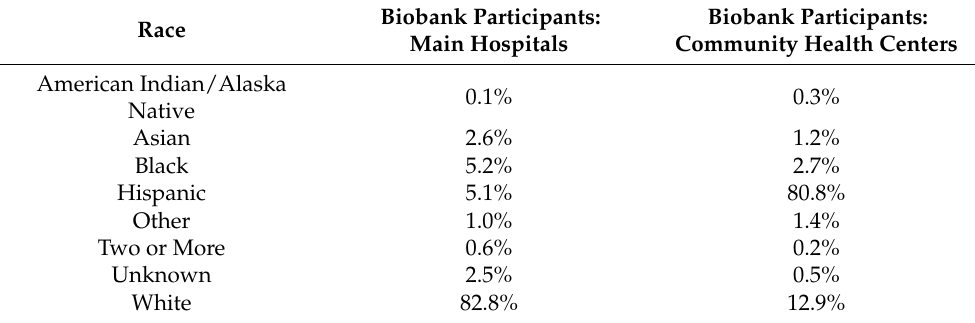
Table 6. Demographics of the Mass General Brigham Hospitals and Community Health Centers. Biobank Participants: Biobank Race Main Hospitals